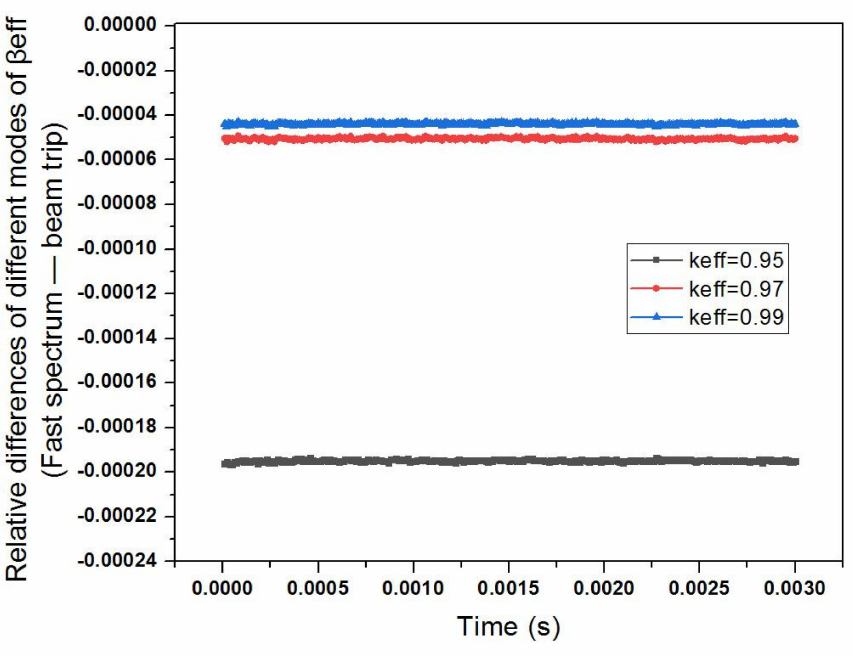
Figure 7. Relative differences in β eff with time for different modes of the fast spectrum, under different subcriticalities and beam trips.